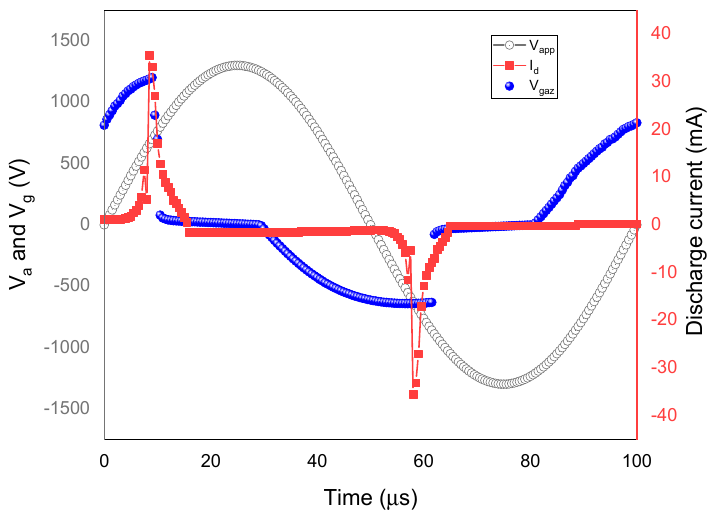
Figure 3. Evolution during one cycle of the calculated applied voltage, gas voltage, and discharge current of the DBD.